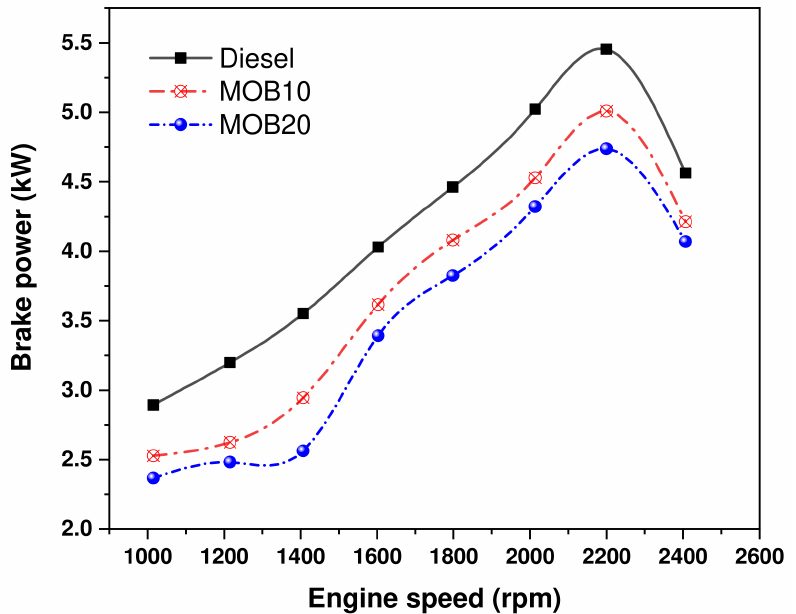
Figure 2. Variation in BP with engine speed for biodiesel blends and